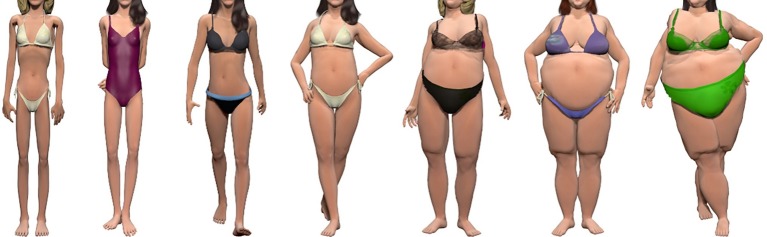
Example CG body image categories from one (left) to seven (right), which were used in the CG bodyline task. The depicted body images were created with CG imagery software, Poser Version 11 (Smith Micro Software, 2015).